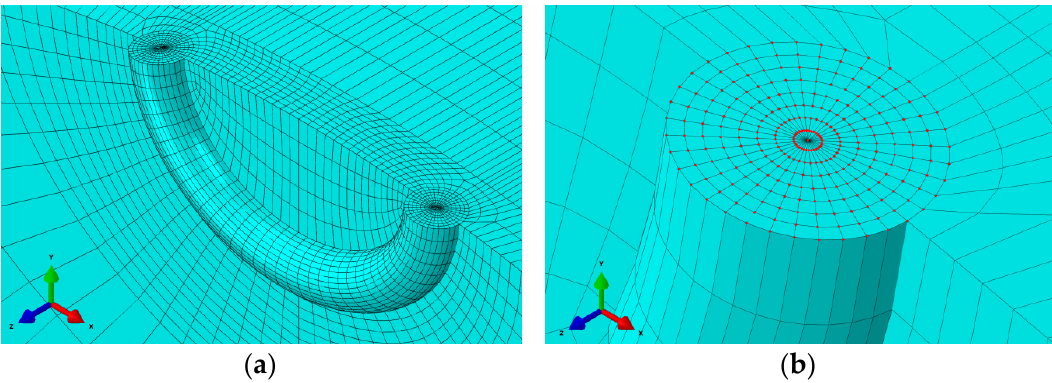
Figure 7. Mesh around crack front for contour integral evaluation; ( a ) Tubular mesh around crack line; ( b ) Detail view of contours at surface